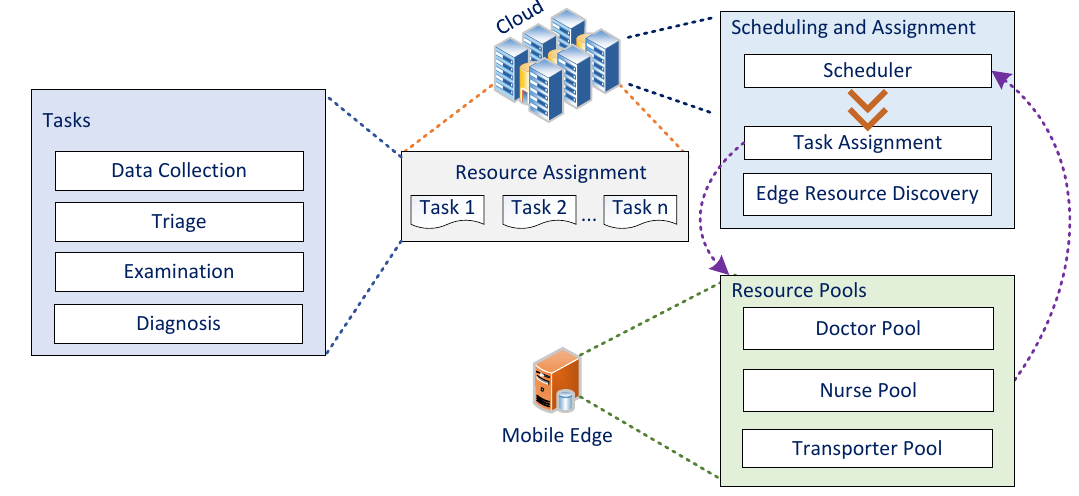
Figure 2. Overview of healthcare resource